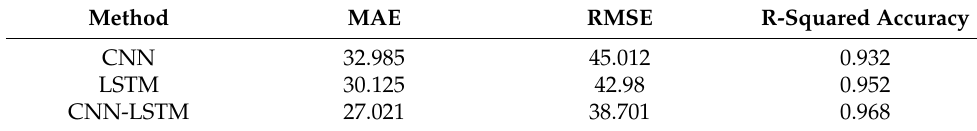
Table 6. Comparison of different evaluation indexes for three methods.